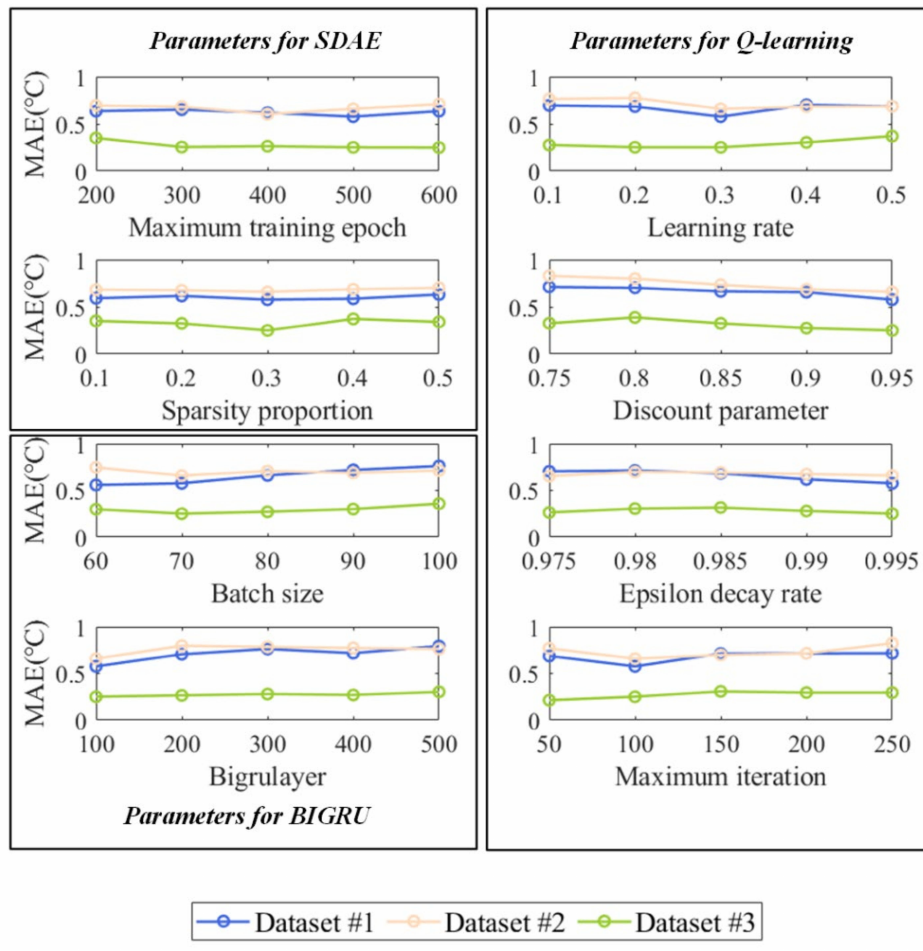
Figure 16. The sensitivity analysis results of the proposed